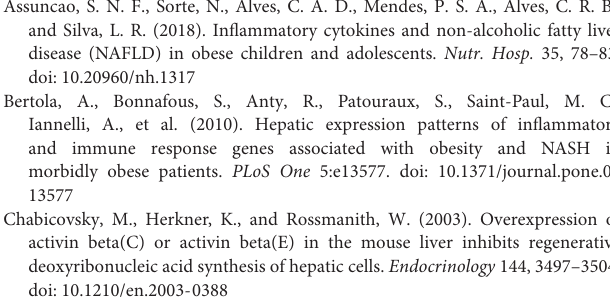
Supplementary Figure 1 | The molecular structures of potential therapeutic drugs. (A) Molecular structures of the digoxin. (B) Molecular structure of the helveticoside. (C) Molecular structure of the anisomycin. (D) Molecular structure of the digoxigenin. Supplementary Figure 2 | The role of OPTN in hepatocellular carcinoma. (A) The expression pattern of 5 hub genes in early stage hepatocellular carcinoma in TCGA and GEO datasets. (B) High expression of OPTN is associated with poor prognosis of hepatocellular carcinoma. Supplementary Table 1 | Immune cell markers.xls. Supplementary Table 2 | Primer sequence.xls. Supplementary Table 3 | Limma results in data.xls. Supplementary Table 4 | The result of